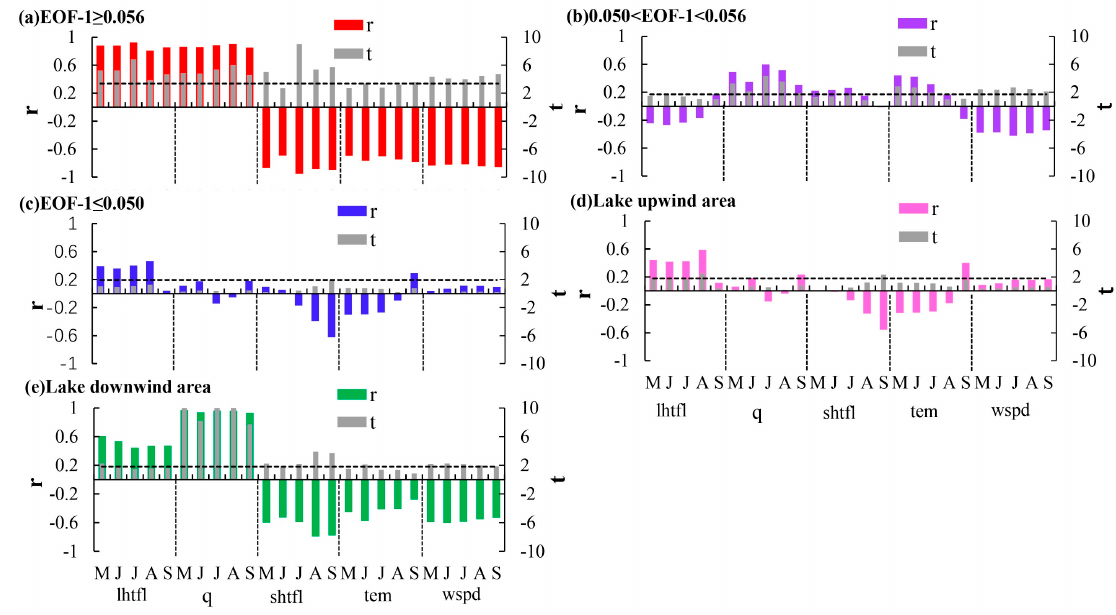
Figure 10. Correlation analysis between precipitation distribution of EOF-1 in different divisions and annual average monthly climate factors (lhtfl, q, shtfl, tem and wspd) at 0.25° × 0.25° grid scale in flood season. ( a ) Correlation analysis between the divisions of EOF-1 ≥ 0.056 and climate factors in corresponding areas; ( b ) Correlation analysis between the divisions of 0.050 < EOF-1 < 0.056 and climate factors in corresponding areas; ( c ) Correlation analysis between the divisions of EOF-1 < 0.05 and climate factors in corresponding areas; ( d ) Correlation analysis between the divisions of EOF-1 in the upwind area and climate factors in corresponding areas; ( e ) Correlation analysis between the divisions of EOF-1 in the downwind area and climate factors in corresponding areas.